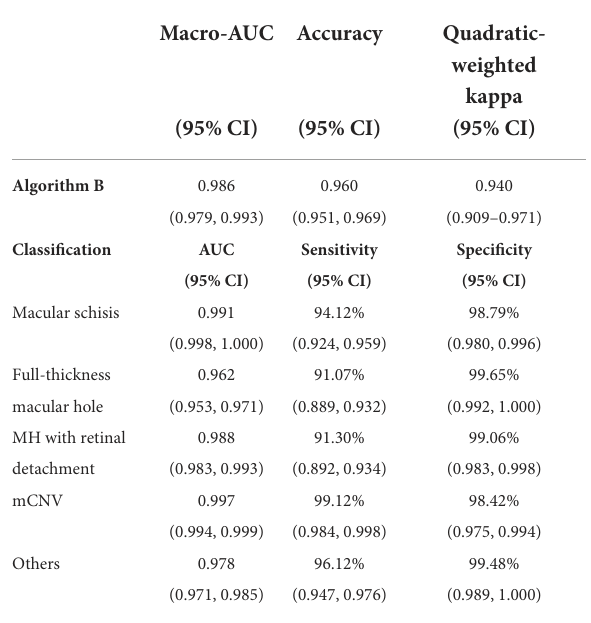
TABLE 2 The performance of the algorithm B in the test